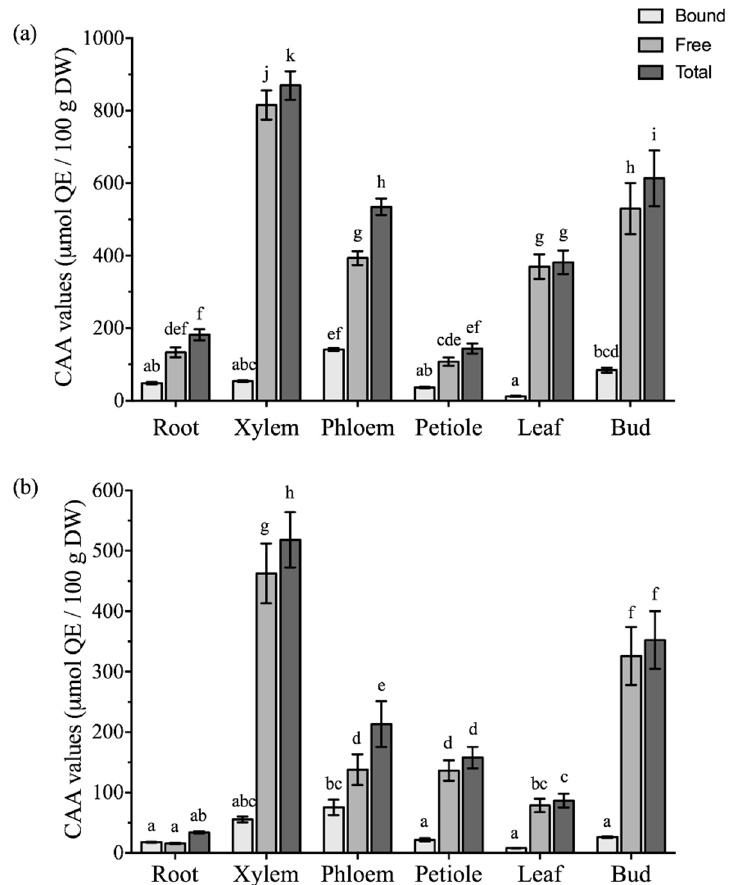
Figure 5. The CAA values of different vegetative parts from Boehmeria nivea L. in ( a ) no PBS wash protocol and ( b ) PBS wash protocol with bound and free fractions (mean ± SD, n = 3). Bars with different letters indicate significant differences among the samples (p < 0.05).